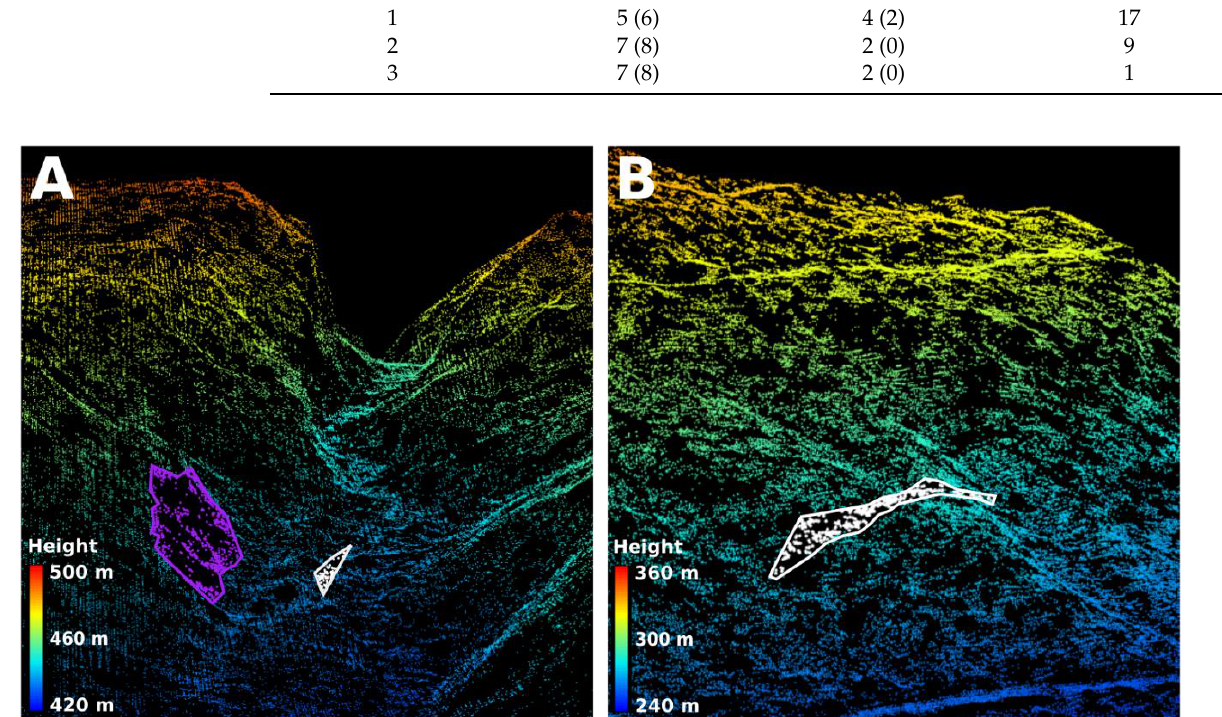
Figure 3. Errors in ground reference data. ( A ) The field observed rock wall assumed to be mislocated and ( B ) the field observed rock wall assumed to be wrong. ALS ground points are colored using height. Identified rock walls are colored white if recorded in the field and purple if identified automatically.